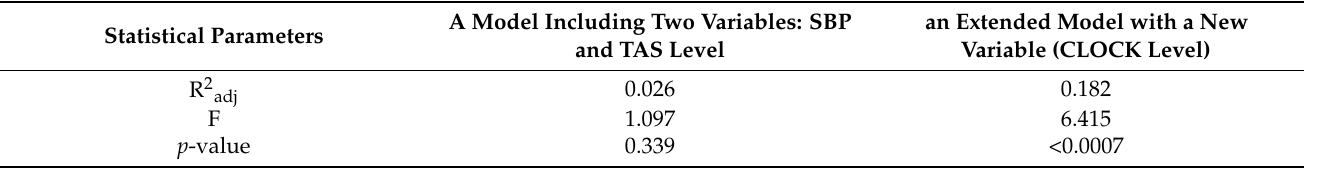
Table 3. Comparison of the stepwise multiple regression model explaining variations of CRY1 levels before and after adding the third variable (CLOCK level) to the basic model, which includes SBP and TAS status in the entire examined population (HT + NHT, n =